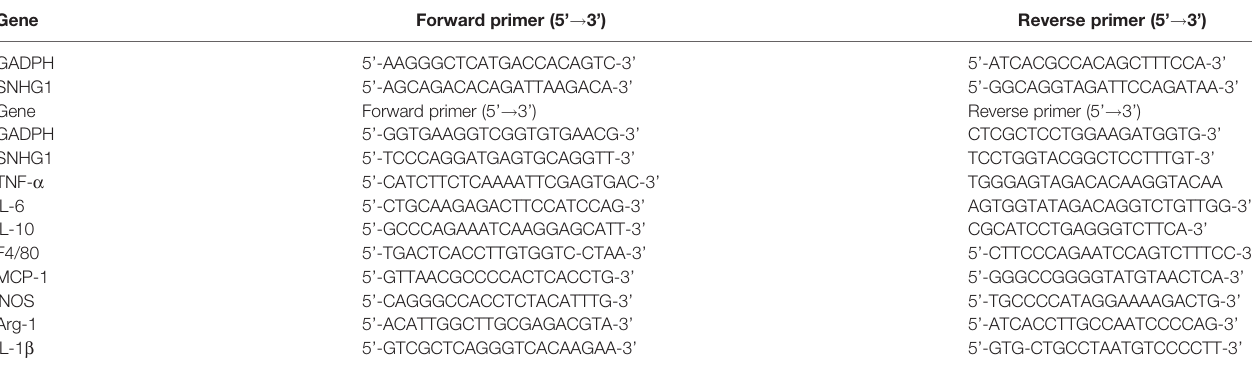
TABLE 1 | Primer sequences for human